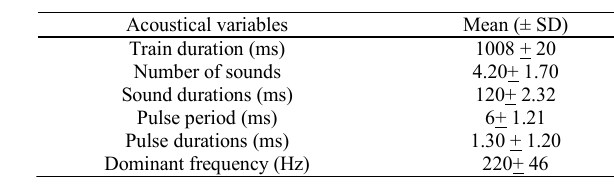
Table 2. Acoustical variables for drumming sound, ms = milliseconds, Hz = Hertz. Number of sounds analyzed n = 98, pulses number analyzed n =